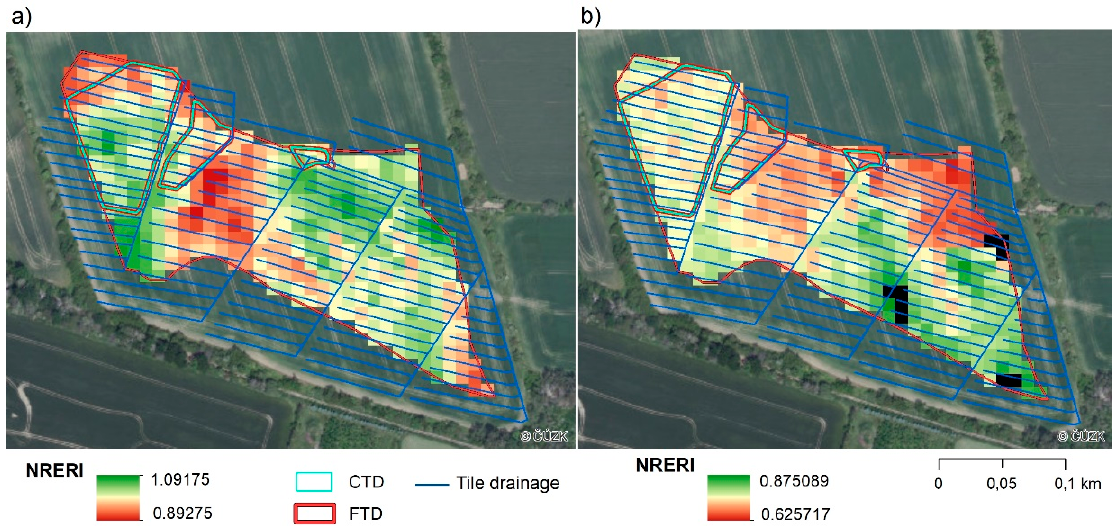
Figure 8. Distribution of NRERI at CTD and FTD sites with Dystric Cambisol (without headlands) of the Za Frajmankou field taken from Sentinel-2 on ( a ) 21 May 2017 and ( b ) 6 May 2018 (excluded outliers in black).